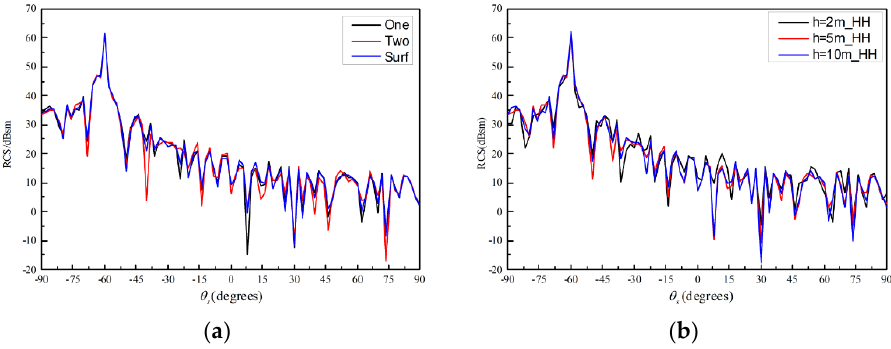
Figure 7. The bistatic scattering: ( a ) from the electrically large rough sea surface without or with one or two missile−like targets above it; ( b ) from two missile−like targets above the electrically large rough sea surface at a different height.